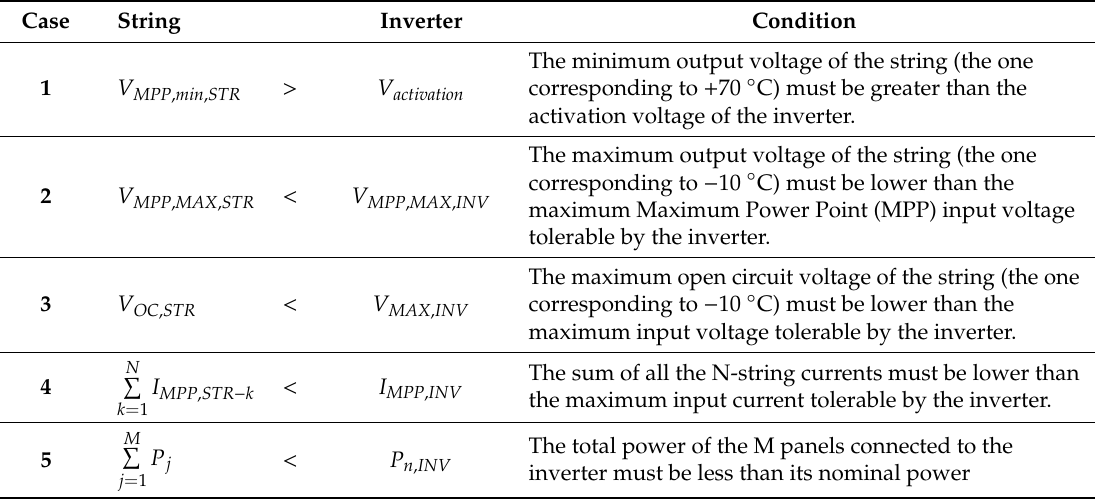
Table 3. String / inverter matching Table 3. String/inverter matching conditions.